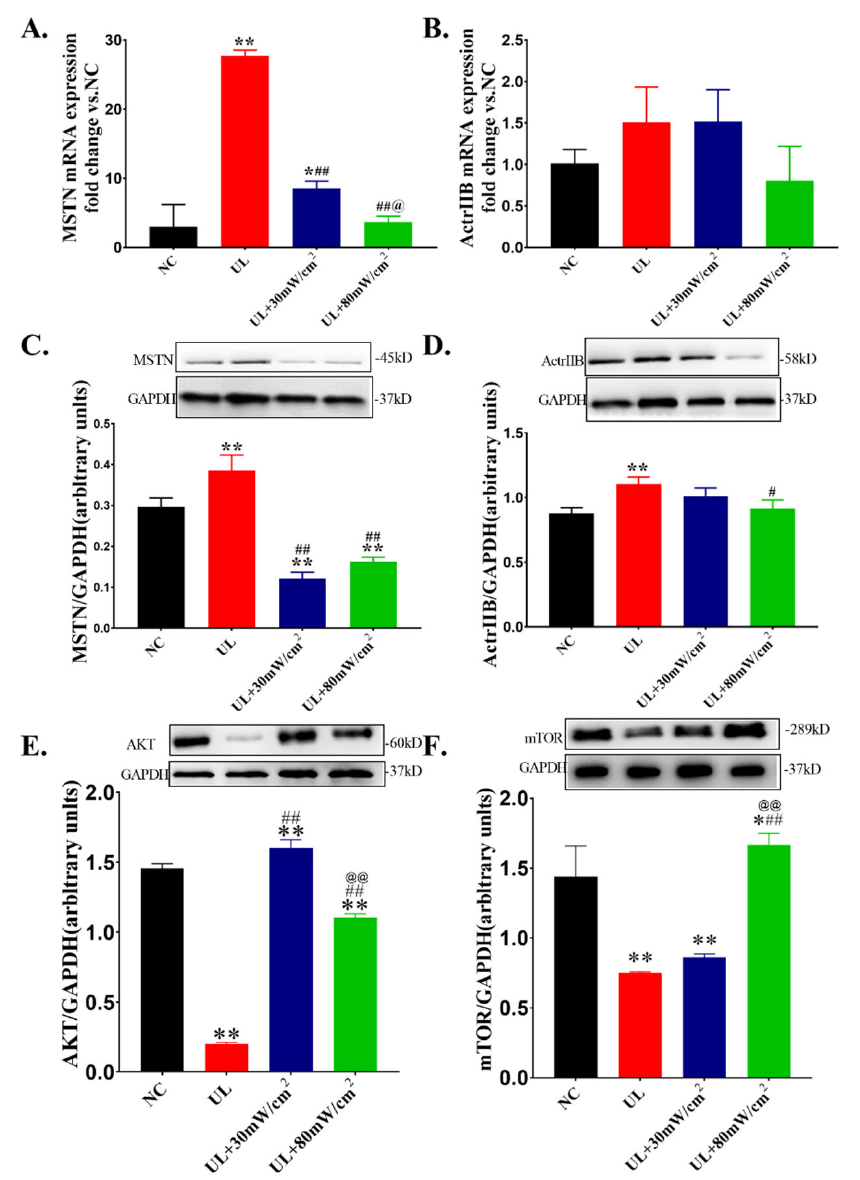
Figure 6. ( A ) The mRNA level of MSTN in gastrocnemius muscle. ( B ) The mRNA level of ActrIIB in gastrocnemius muscle. ( C ) The protein level of MSTN in gastrocnemius muscle. ( D ) The protein level of ActrIIB in gastrocnemius muscle. ( E )The protein level of AKT in gastrocnemius muscle. ( F ) The protein level of mTOR in gastrocnemius muscle. The data were expressed as mean ± SD ( n = 3 in each group), ** p < 0.01 vs. NC group, * p < 0.05 vs. NC group, ## p < 0.01 vs. UL group, # p < 0.05 vs. UL group, @@ p < 0.01 vs. 30 mW/cm 2 group, @ p < 0.05 vs. 30 mW/cm 2 group.